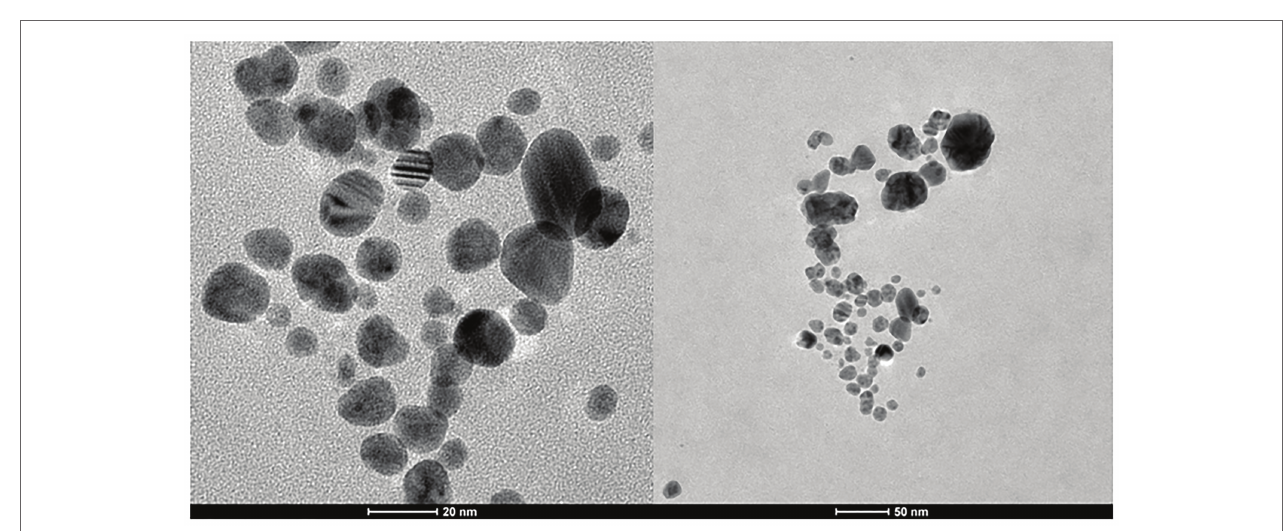
FIGURE 2 | TEM of biosynthesized